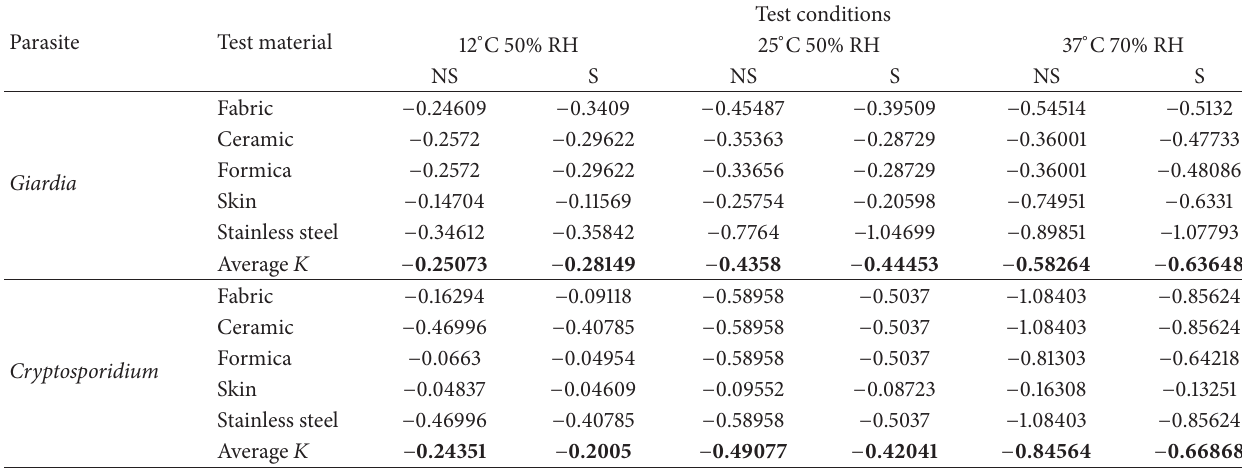
Table 1: Summary of die-off rates (the first-order 𝐾 values) of Giardia cysts and Cryptosporidium oocysts on a variety of surfaces incubated in different environmental